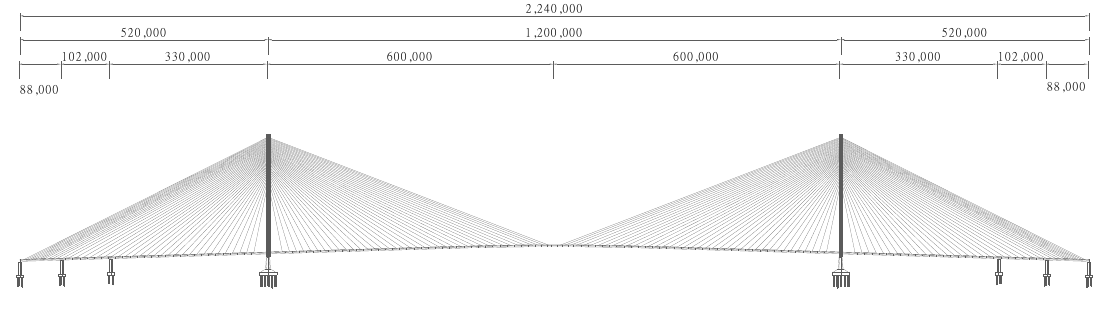
Figure 2. Geometry of the target cable-stayed bridge (unit: mm).